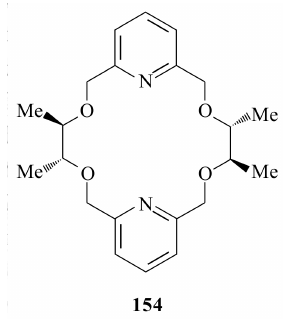
Figure 32. Pyridino-crown-ether synthesized from 2,6-pyridine